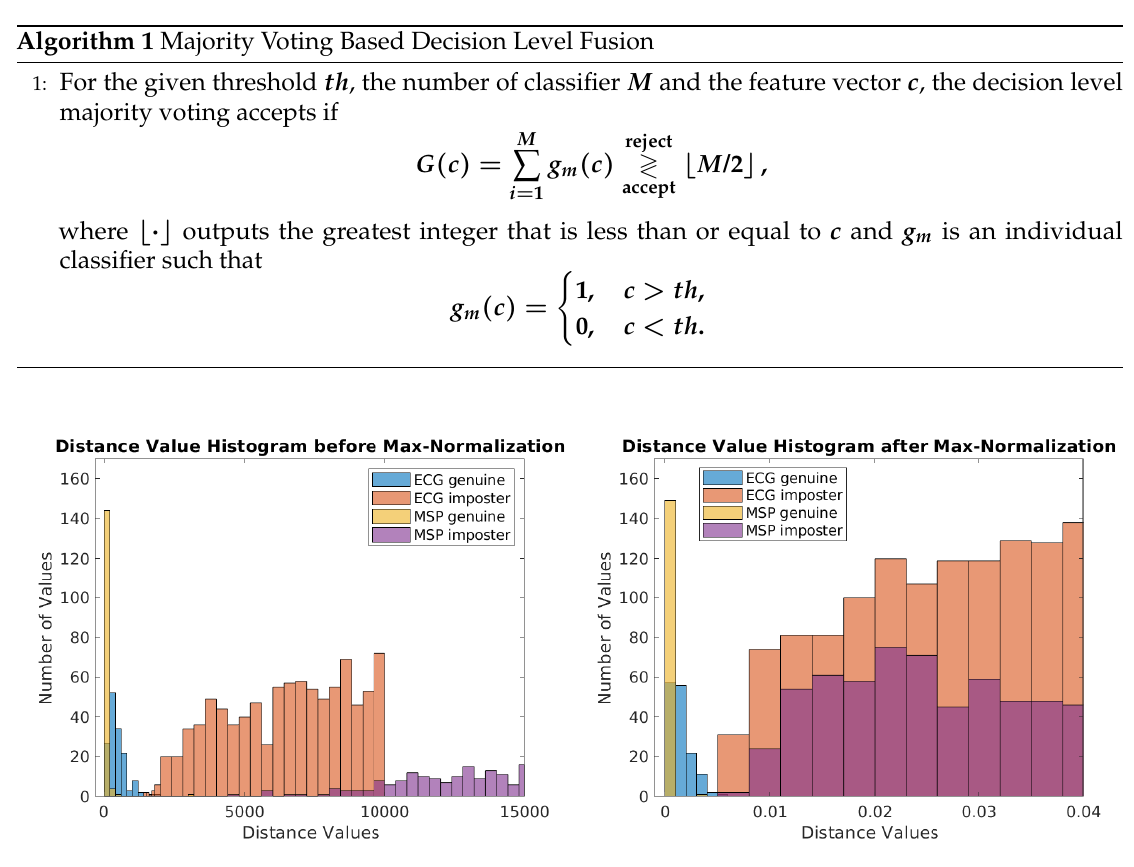
Figure 10. A comparison of the histograms of distance values before ( left ) and after ( right ) the normalization by the maximum distance. A distance value refers to an Euclidean distance between a user template and a tested biometric signal (ECG or MSP) of the genuine user or an